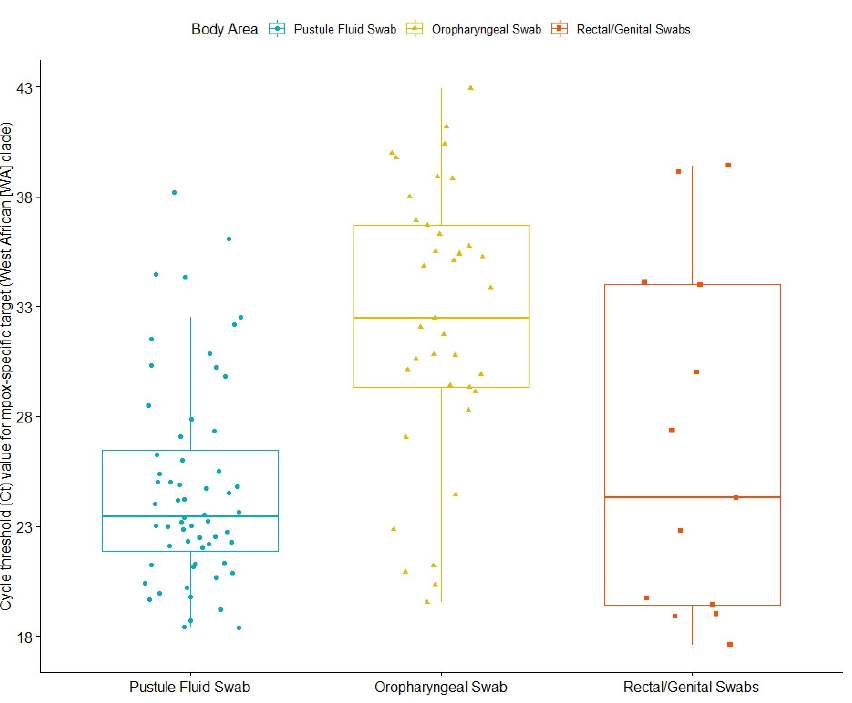
Figure 2. Cycle threshold (Ct) values for Mpox-specific targets (West African (WA) clade) of Mpox patients. The box plot indicates the interquartile range and median value; the whiskers indicate extreme data points.